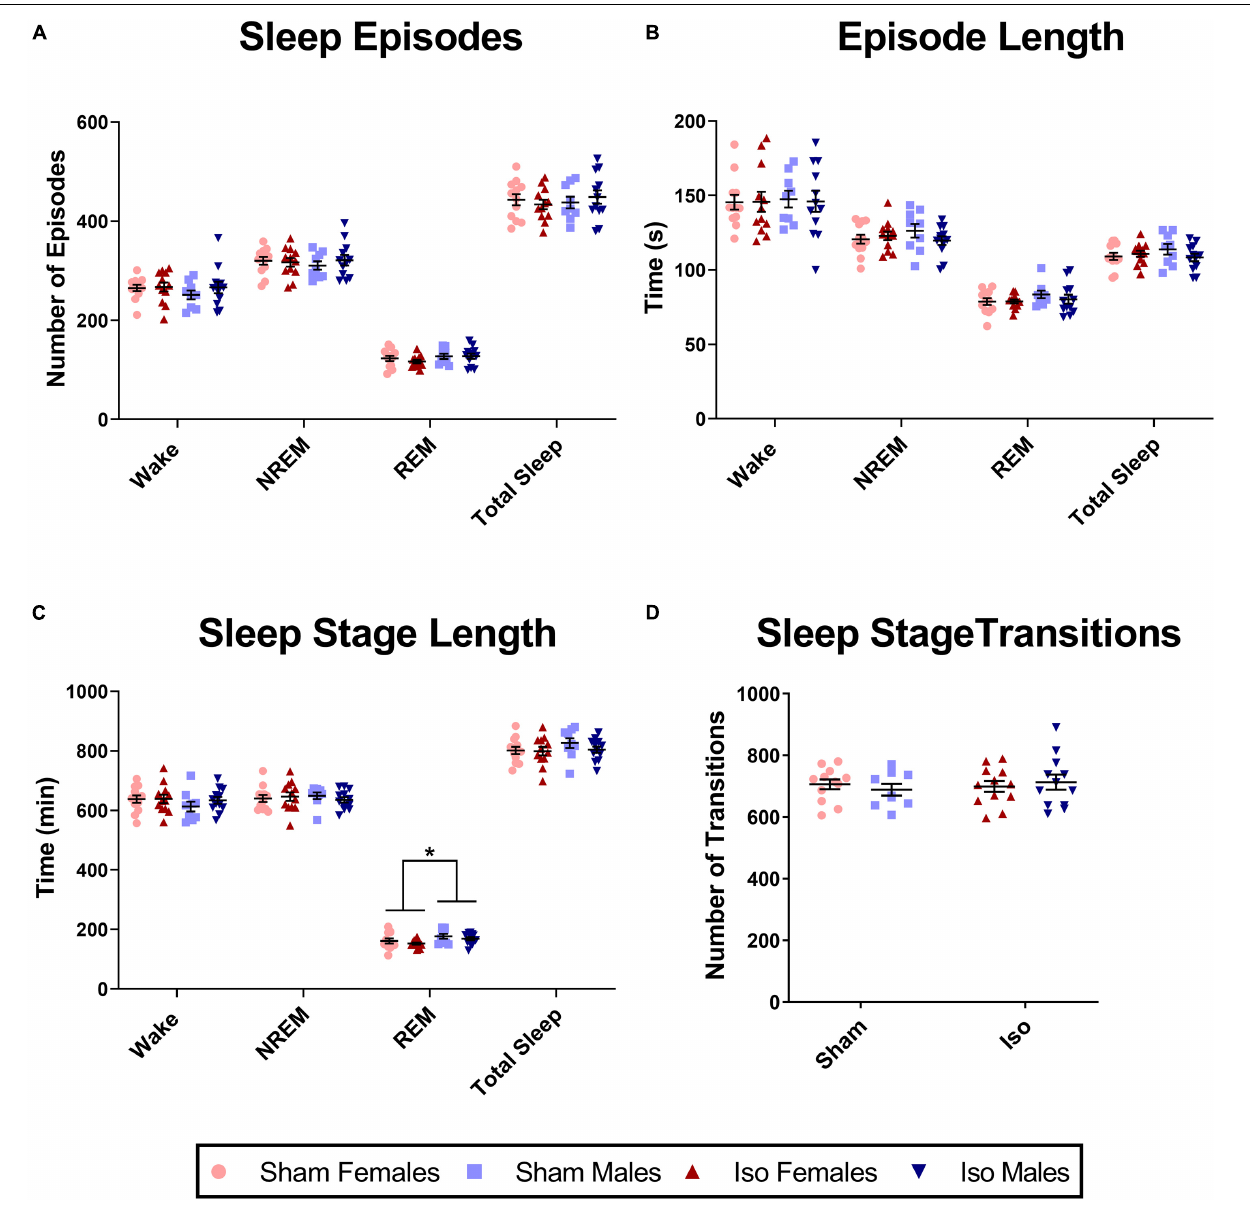
FIGURE 4 | Exposure to neonatal isoflurane does not affect sleep architecture. (A) Exposure to neonatal isoflurane did not result in any changes in the number of episodes in the Wake ( P = 0.374), NREM ( P = 0.869), REM ( P = 0.534), and total Sleep stages ( P = 0.953). (B) Corresponding to the number of episodes, the average length of each episode also did not differ between groups for Wake ( P = 0.917), NREM ( P = 0.507), REM ( P = 0.524), and total Sleep ( P = 0.483). (C) Despite sex differences (* P = 0.022), there were no changes in total time spent in each stage after neonatal isoflurane exposure for Wake ( P = 0.434), NREM ( P = 0.753), or REM ( P = 0.210). (D) Finally, rats did not differ in transitioning between the different stages, and this was consistent in the light cycle ( P = 0.658), dark cycle ( P = 0.820), and when cycles were combined ( P =